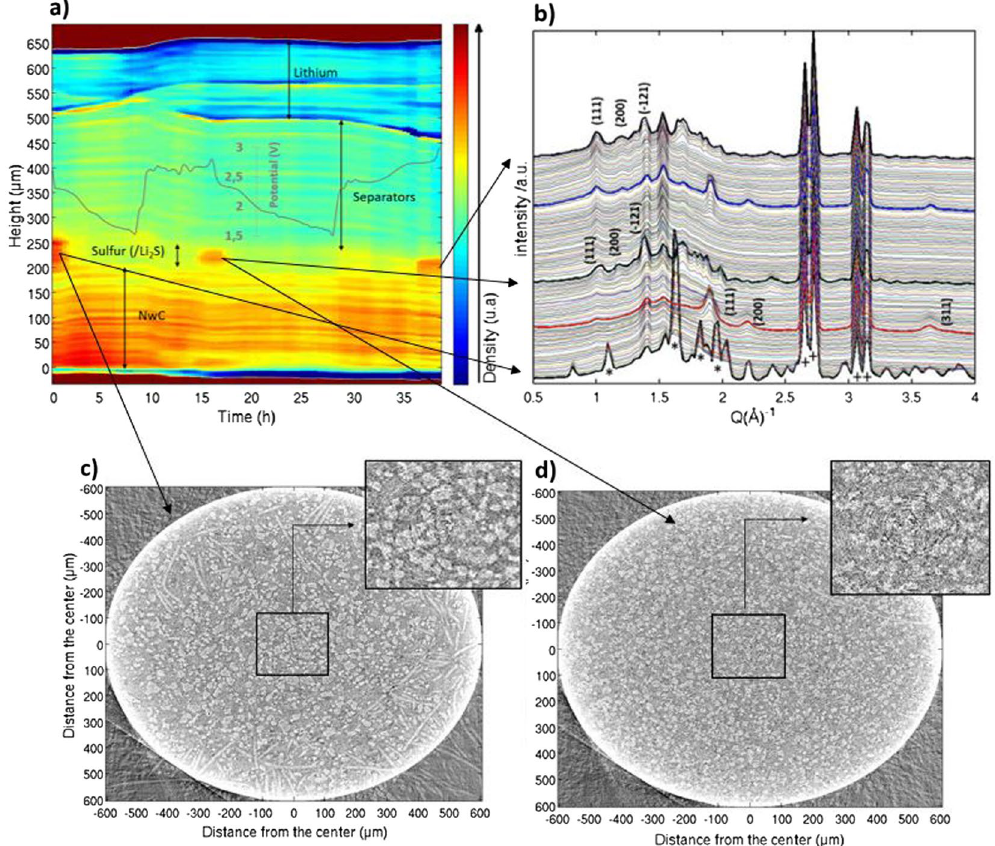
Figure 5. ( a ) Integration over a plane of the 3D tomographic reconstruction showing median pixel values within each vertical layer during the two first cycles. ( b ) Corresponding time evolution of the XRD pattern in the 200 µ m slice, corresponding to the top of the NwC. ( c ) Horizontal slice in the carbon binder – sulfur domain, in the initial state and zoom of the 400 µ m 2 indicated. ( d ) Horizontal slice in the carbon binder – sulfur domain, at the end of first charge and zoom of the 400 µ m 2 square